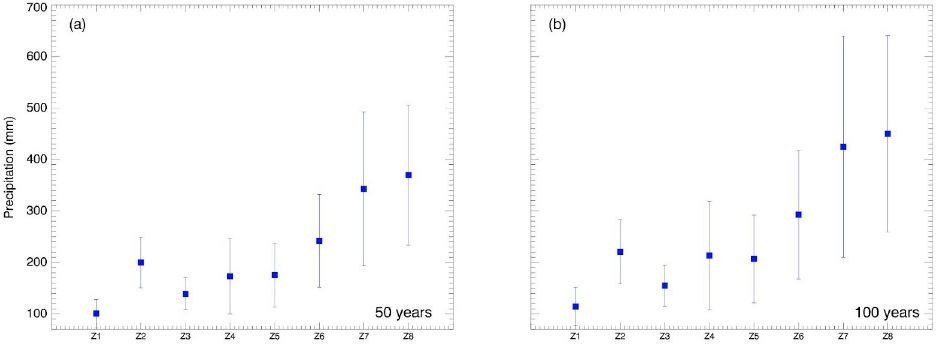
Figure 12. Return levels (daily precipitation) and respective dispersion intervals for the representative stations listed in Table 1 (Z1–Z8) obtained at 50 ( a ) and 100 ( b )